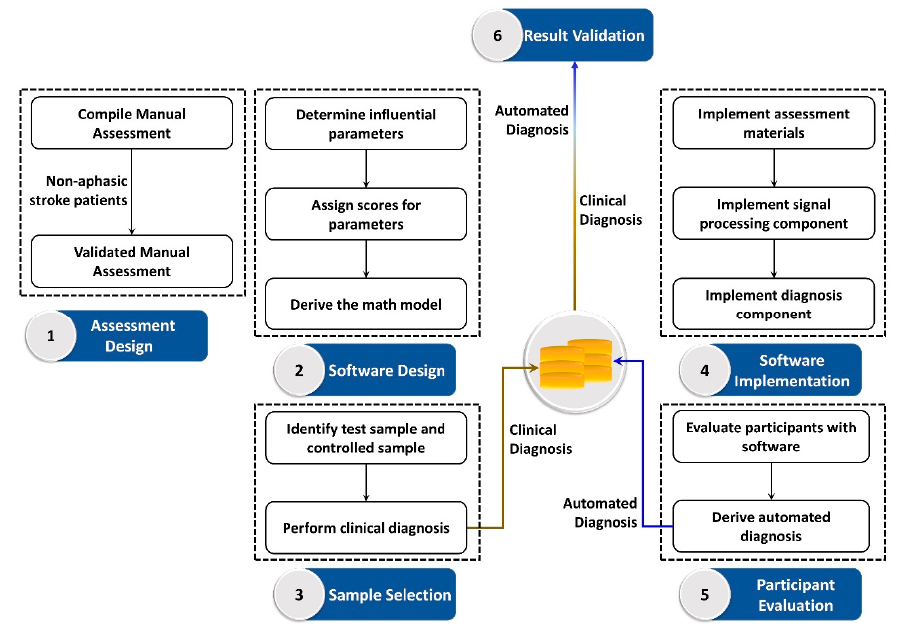
Figure 1. Workflow of the proposed quantitative aphasia assessment tool.